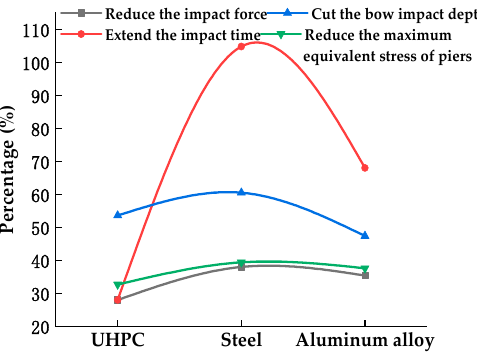
Figure 19. Collision avoidance performance of the device under different material support elements.